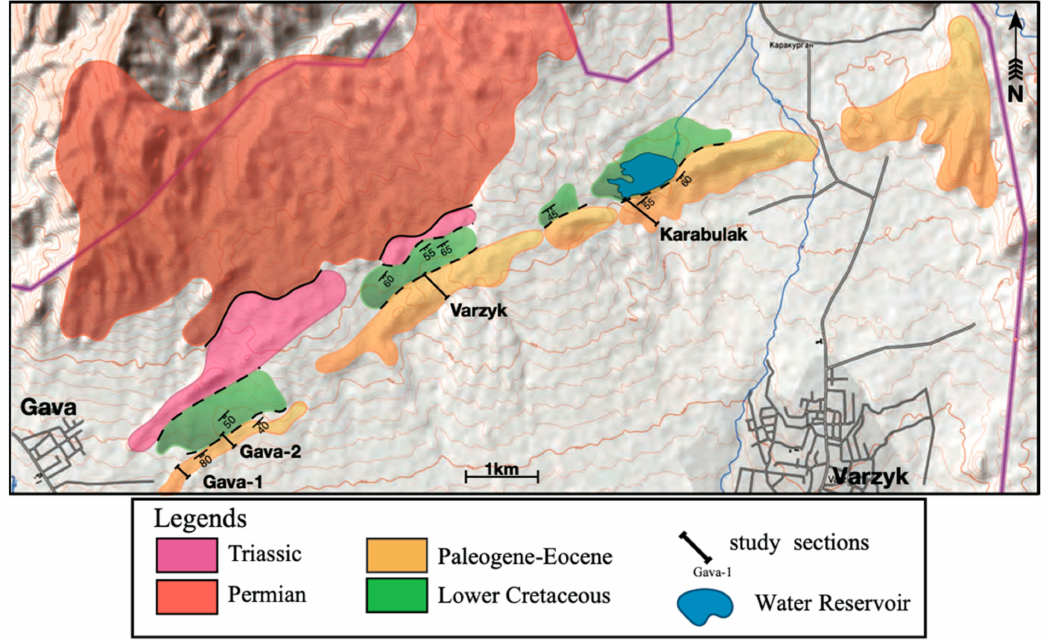
Figure 2. Outline geological map of the northern part of the Fergana Basin within the territory of the Republic of Uzbekistan, at the southern foothills of the Chatkal Range close to the villages of Gava and Varzyk, and the Karabulak water dam. The locations of the studied sections are